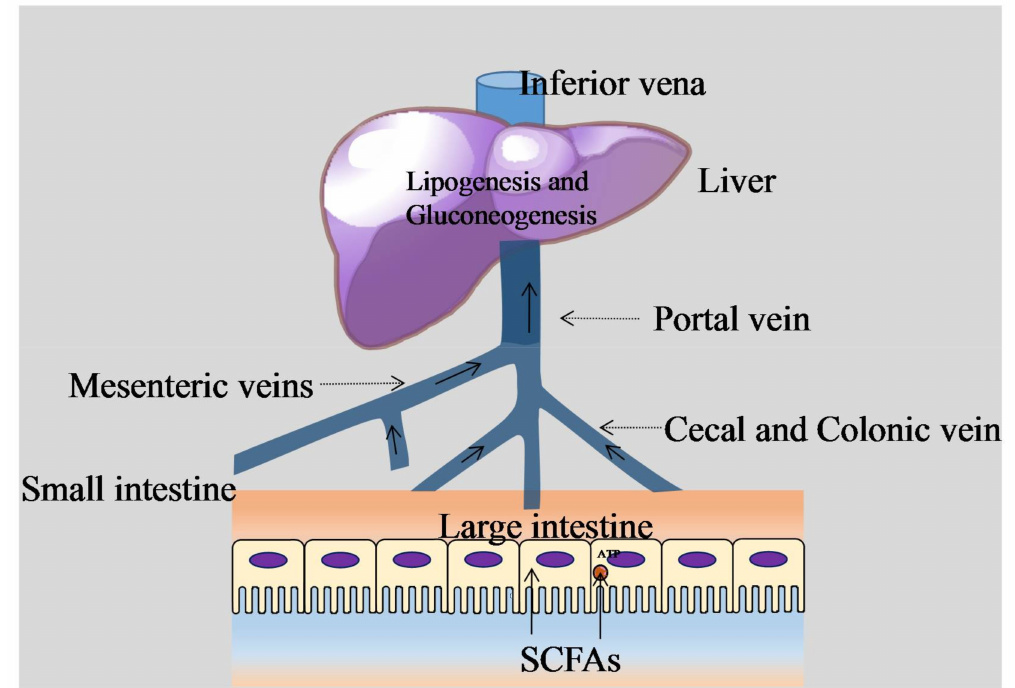
Figure 2. SCFAs in liver circulation and central metabolism. Butyrate, propionate, and acetate enter the liver via the portal vein after passing through the mesenteric veins, cecal veins, and colonic veins. They are then utilized for lipogenesis and gluconeogenesis in the liver, the products of which then enter blood circulation. SCFAs are an important source of energy (in the form of ATP) for colonocytes and for gluconeogenesis in the modulation of the central